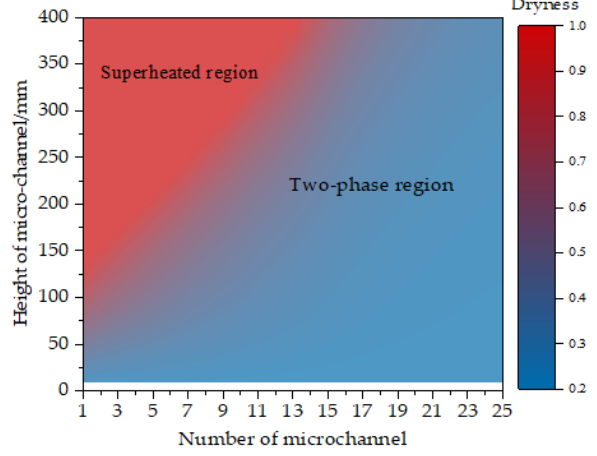
Figure 8. Refrigerant dryness in the microchannels.